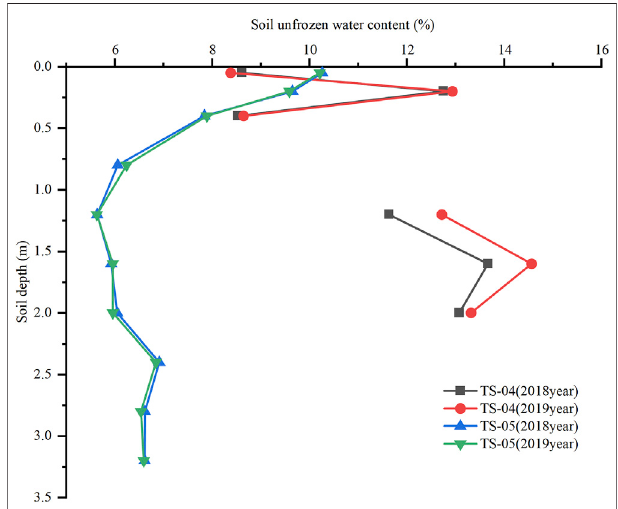
FIGURE 13 | Envelope of soil unfrozen water content under different vegetation